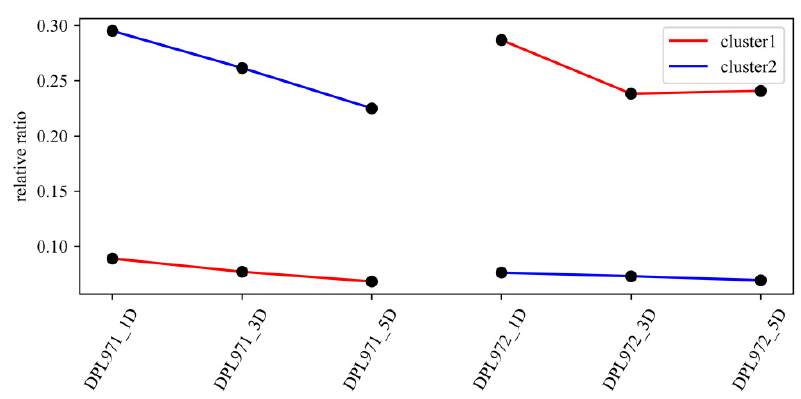
Figure 7. K-means clustering of DEGs in the MEmagenta module.